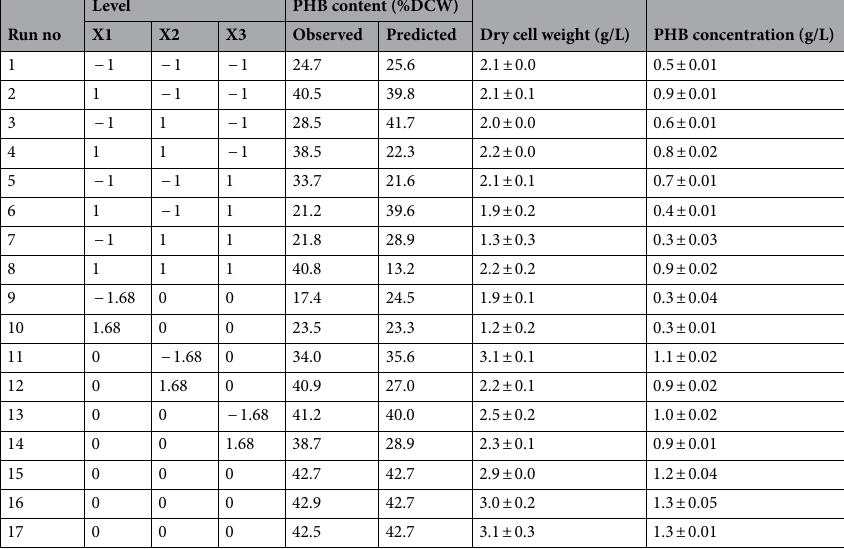
Table 1. Experimental design and result of central composite design (CCD) of response surface methodology.